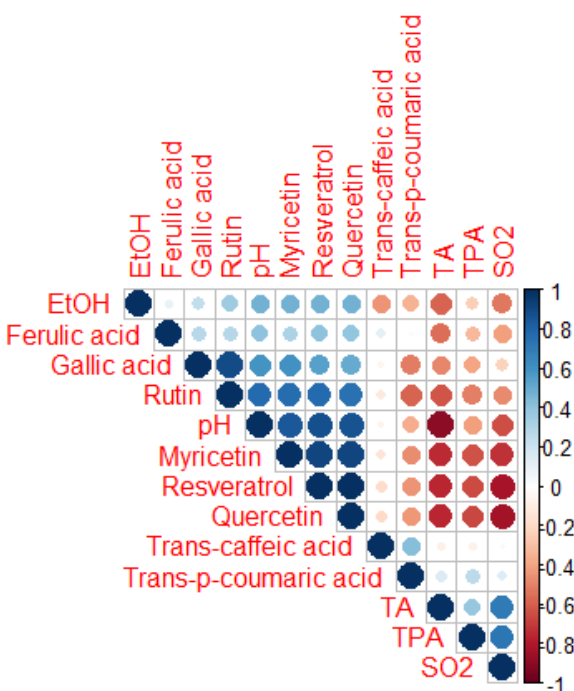
Figure 2. Visual processing of the Pearson correlation of the tested parameters. Visual processing of the Pearson correlation of the tested parameters is shown in Figure 2. Positive correlations are shown in blue, while negative correlations are shown in red. The following applies to the size of circular objects—the larger the object, the higher the correlation.